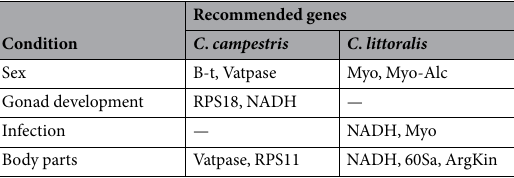
Table 4. Selection of recommended genes for each species and condition according to the results of geNorm , NormFinder , Bestkeeper and Δ C T